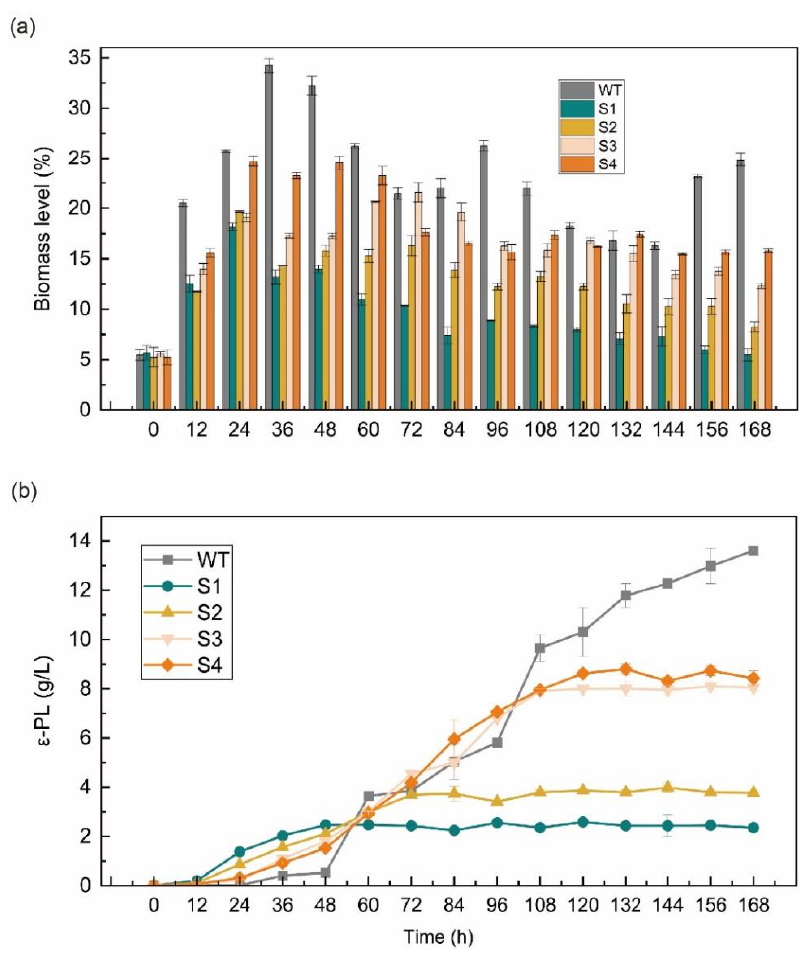
Figure 2. Biomass level and ε -PL production of the S. albulus strain under 168 h fed-batch fermenta- tions. ( a ) Biomass level of the WT and four repressed strains; ( b ) ε -PL production of the WT and four repressed strains. The data represent the means of three samples per time interval, and the error bars represent the standard deviation. Some error bars cannot be seen due to small standard deviations.